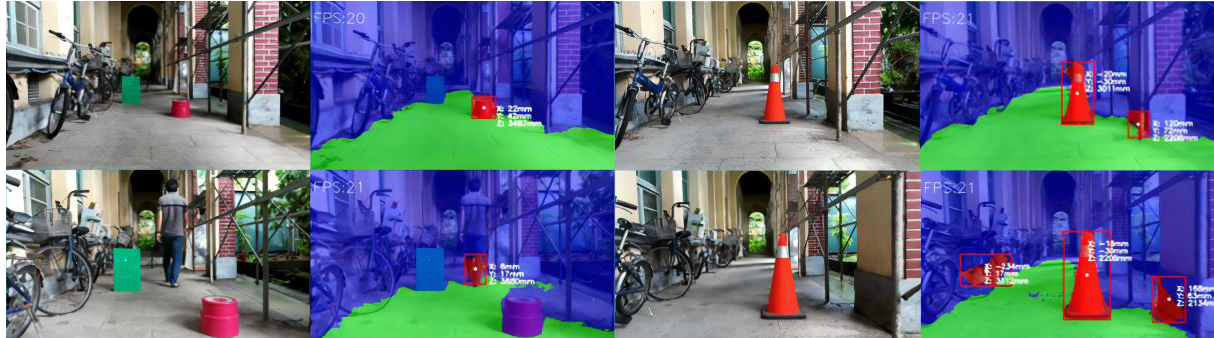
Figure 7. The real-time segmentation results with pre-trained FuseNet network on AGSL